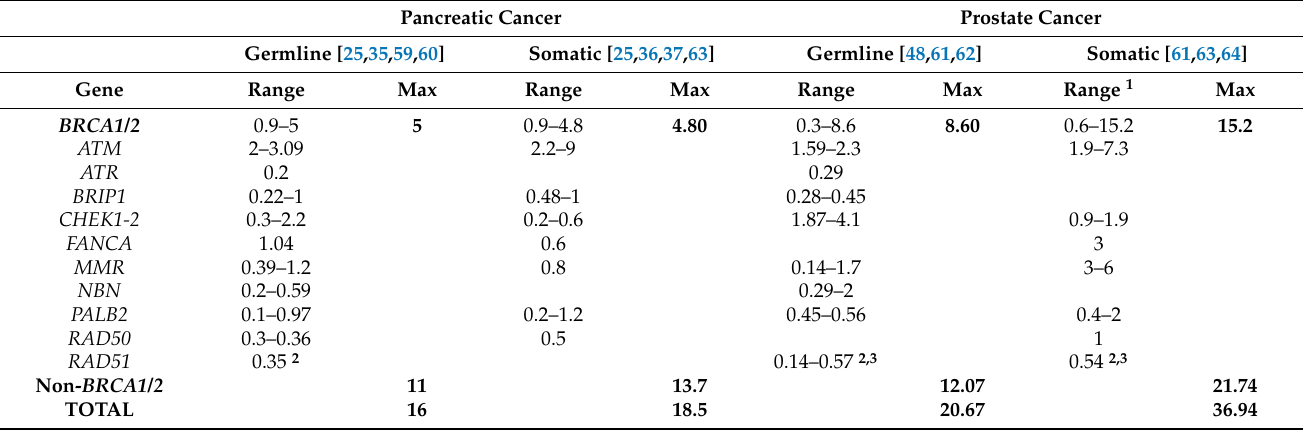
Table 1. Frequency of the pathogenic variants in DDR genes shared by pancreatic and prostate